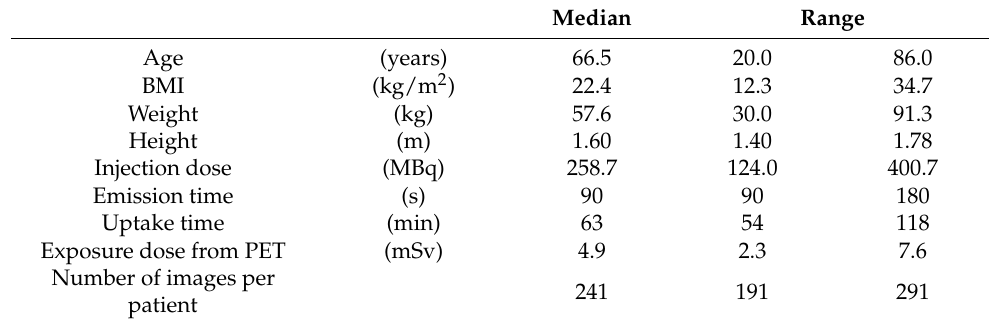
Table 1. Patient characteristics and scan parameters in clinical